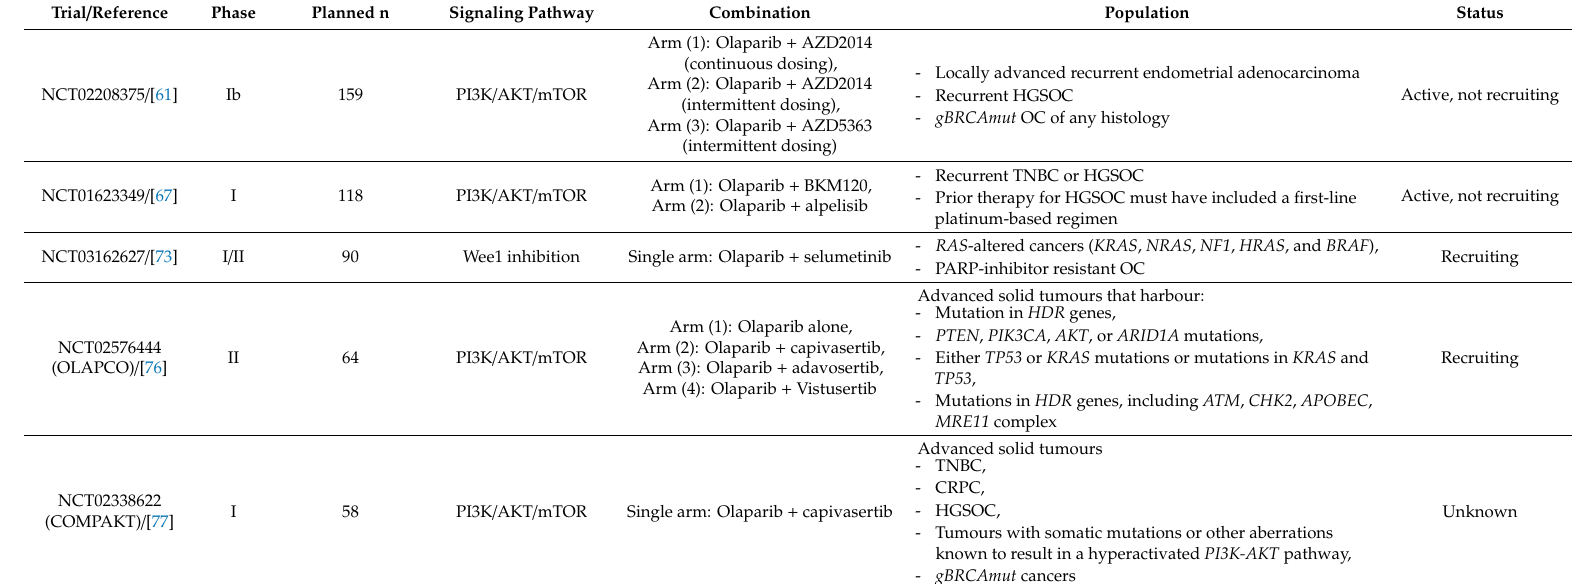
Table 3. Ongoing combination trials with olaparib and other cell signaling pathway inhibitors